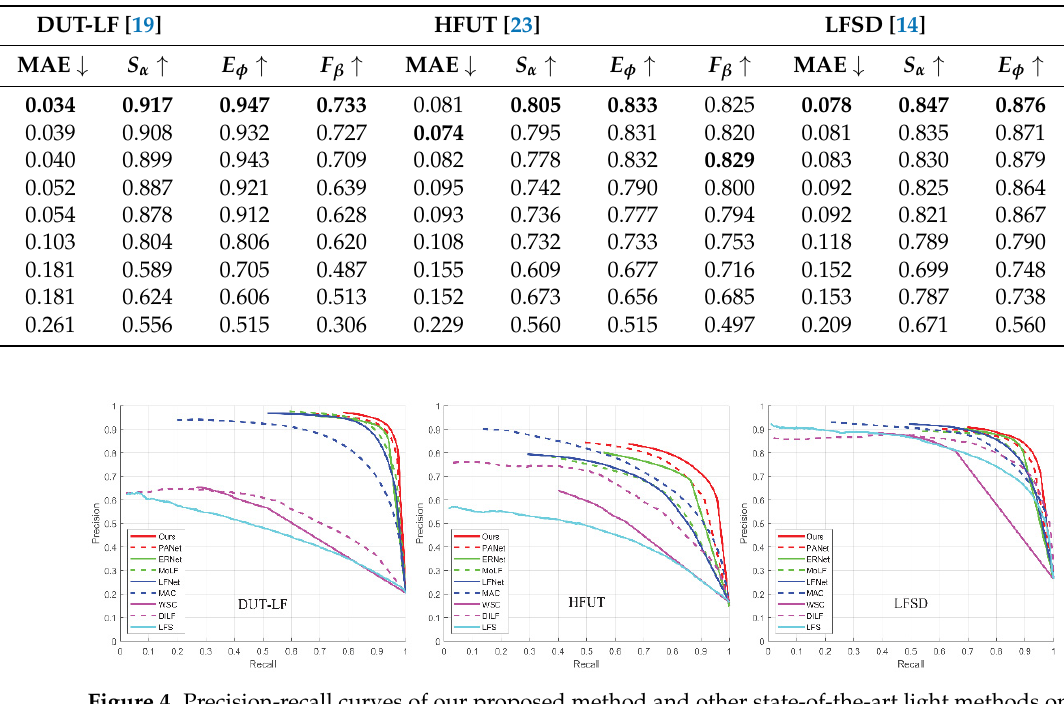
Figure 5. Qualitative comparison with the state-of-the-art methods. 4.3. Comparison of Edge Feature Extraction Approaches We compare different edge feature extraction methods in terms of both feature ex- tractors and extraction sources to verify the effectiveness of EFEM. First, we remove EFEM from the network shown in Figure 1 to build the baseline network. Then, we implement experiments on different edge feature extraction approaches. 4.3.1. Comparison of Edge Feature Extractors We compare the effect of a convolutional layer and our proposed EFEM on the net- work. The quantitative results are shown in Table 2 (b) and (d), it can be seen that EFEM presents better performance on all datasets (12.8%, 7.1%, and 6.0% improvement in MAE). The qualitative results are shown in Figure 6b,d, which demonstrate that EFEM is more favorable to improve the edge details of salient objects.